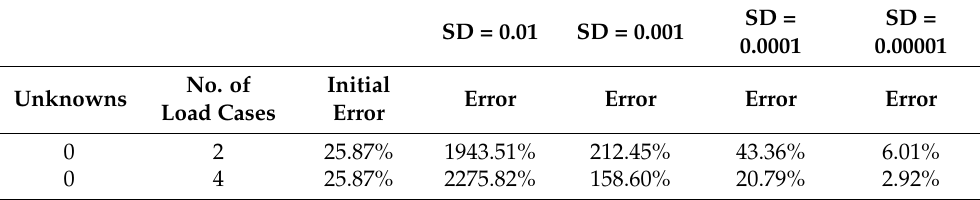
Table 13. Errors obtained for thermal parameters for transient 16 nodes model.